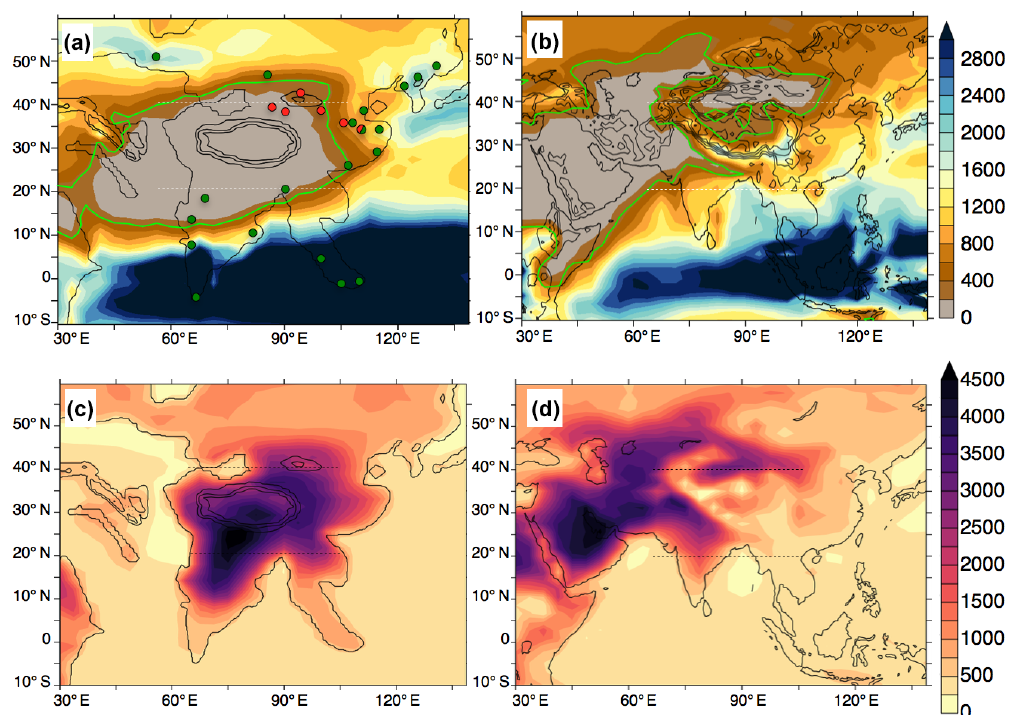
Figure 6. (a, b) Mean annual precipitations (mmyr − 1 ) for the (a) EOC4X simulation and (b) the control simulation. The green outline delimits the arid region receiving less than 1mmd − 1 . (c, d) Water condensation altitude (in metres) in July for the (c) EOC4X simulation and (d) control simulation. Horizontal dotted lines show the latitude used for the meridional profiles in Fig. 5. In (a) , circles indicate locations of palaeovegetation studies and describe forested environment (green) and shrub/grass environment (red), according to qualitative descriptions described in Table